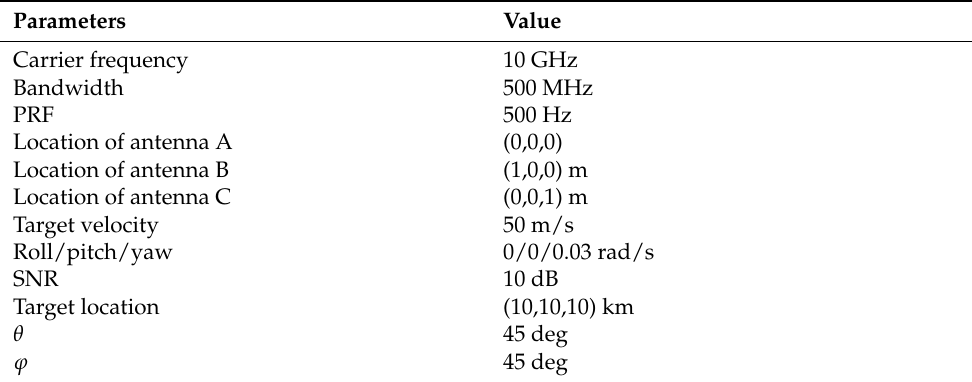
Figure 5. Target model in ( a ) 3D; ( b ) projection on x-y plane; ( c ) projection on x-z plane; ( d ) projection on y-z plane. Table 1. Simulation parameters of the InISAR system.